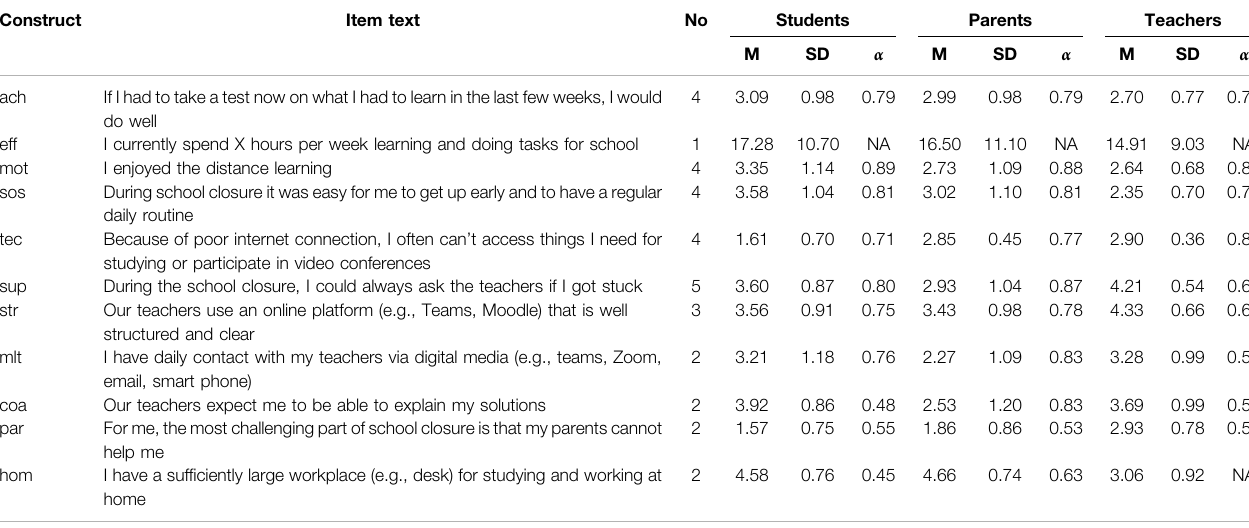
TABLE 2 | Descriptive statistics and reliability information for the study variables in the three samples.